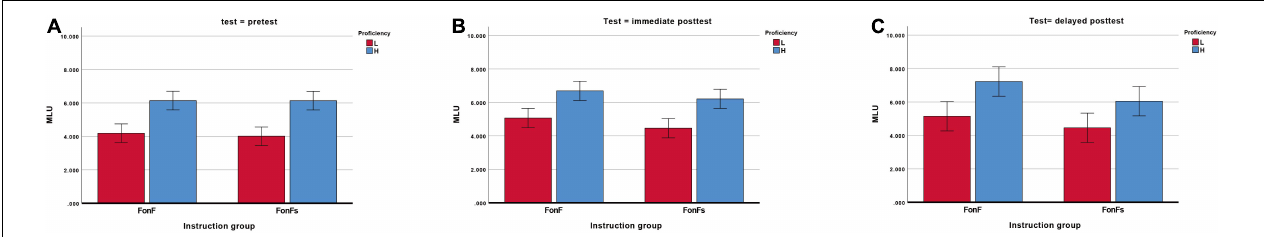
FIGURE 1 | Effects of different instruction methods on fluency (MLU). (A) The MLU of the pretest. (B) The MLU of the immediate posttest. (C) The MLU of the delayed posttest.